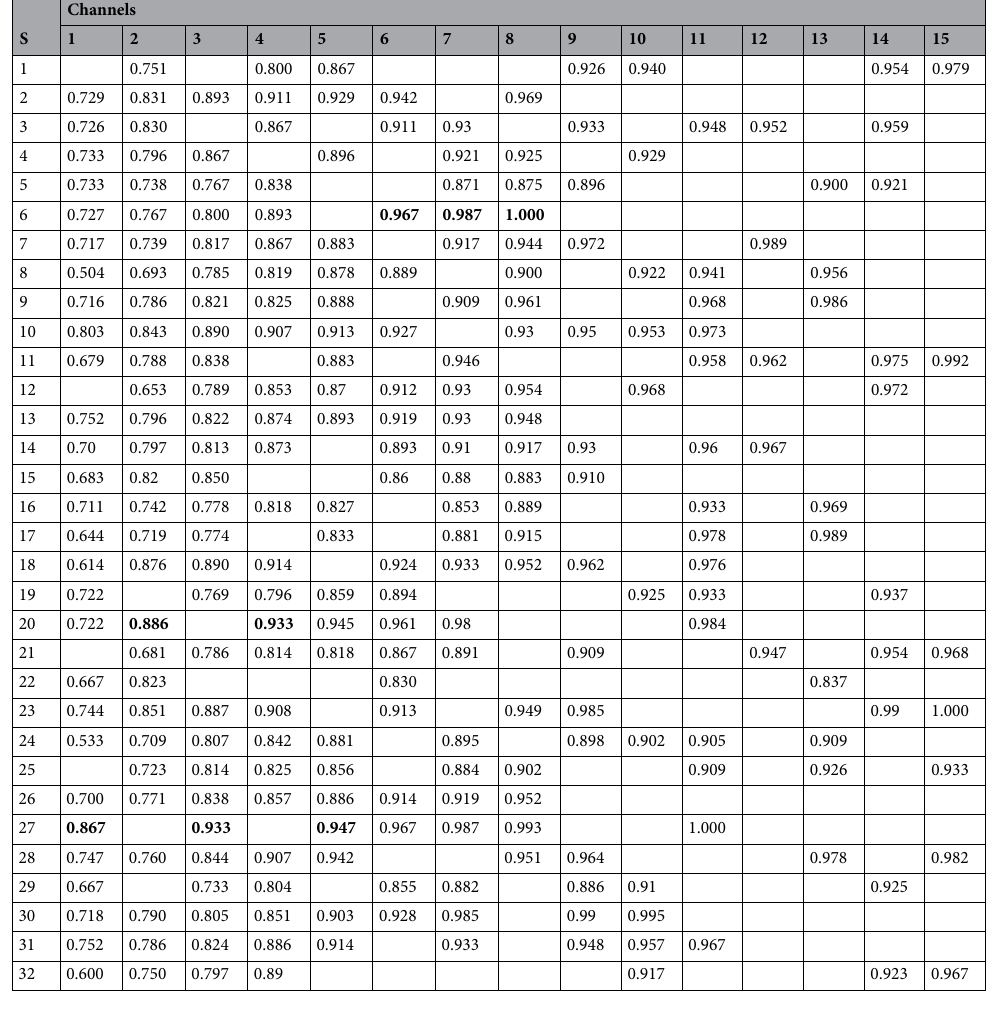
Table 3. Low vs high arousal classification accuracies obtained with EEGNet. Accuracies obtained in the Pareto-front for the first 1–15 channels selected by NSGA-II. The subjects with the highest accuracies per channel set are indicated in